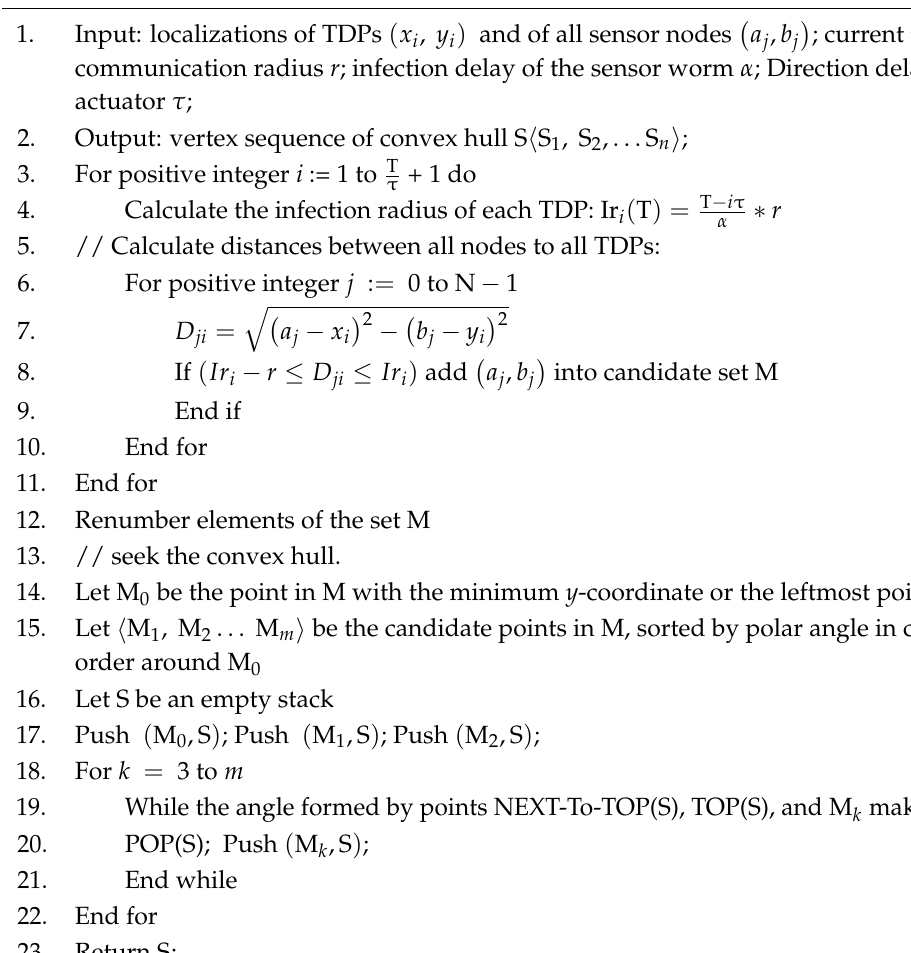
Algorithm 1: Estimating the Geometry Boundary of Infected